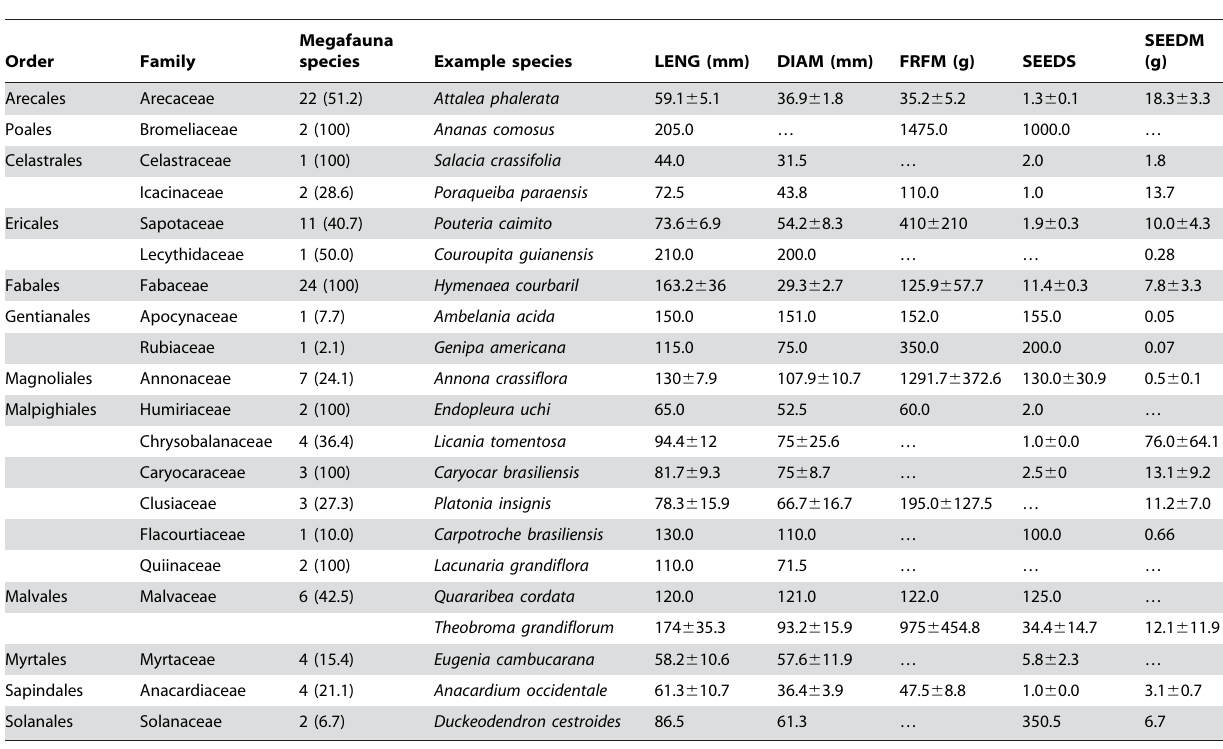
Table 1. Relative representation of the megafauna syndrome fruits in angiosperm families and summary of fruit trait variation among species.